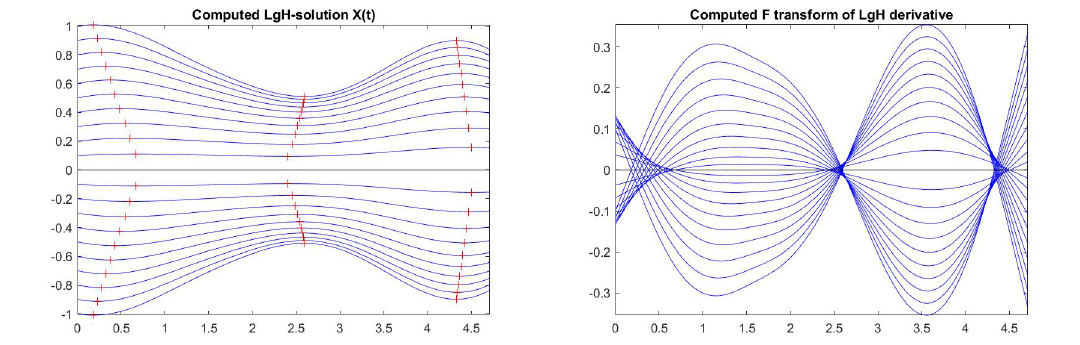
Figure 11. Problem IDE2, Meth = 1: Level-wise LgH-differentiable solution ( left ) and its LgH- derivative ( right ). For all α -cuts, there are three switching points which are not in the same position for the levels α ( left ); on right , the LgH-derivatives are represented.